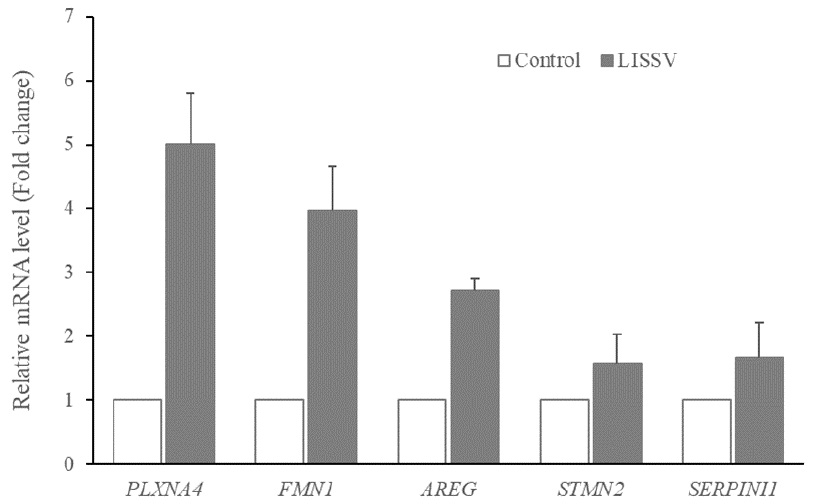
Figure 1. Expression of genes in human umbilical-cord-derived mesenchymal stem cells after low- intensity sub-sonic vibration treatment using RNA sequencing. Cells were harvested 4 days after LISSV treatment. Fold change in expression of Plexin-A4 ( PLXNA4 ), Formin 1 ( FMN1 ), Amphiregulin ( AREG ), Stathmin 2 ( STMN2 ), and Serpin Family I Member 1 ( SERPINI1 ). Assayed using real-time polymerase chain reaction. Column heights correspond to mean values and error bars to standard deviations ( n =